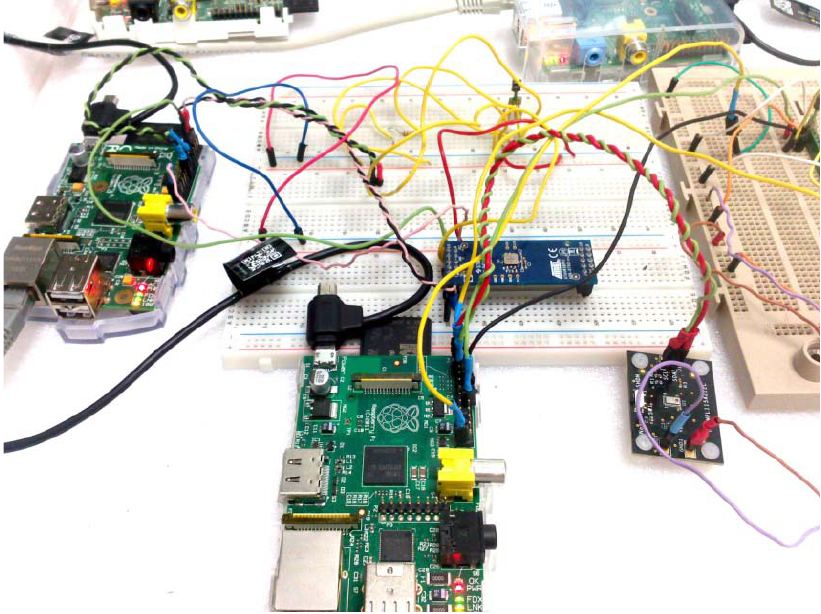
Figure 3. Devices used in the prototype development.